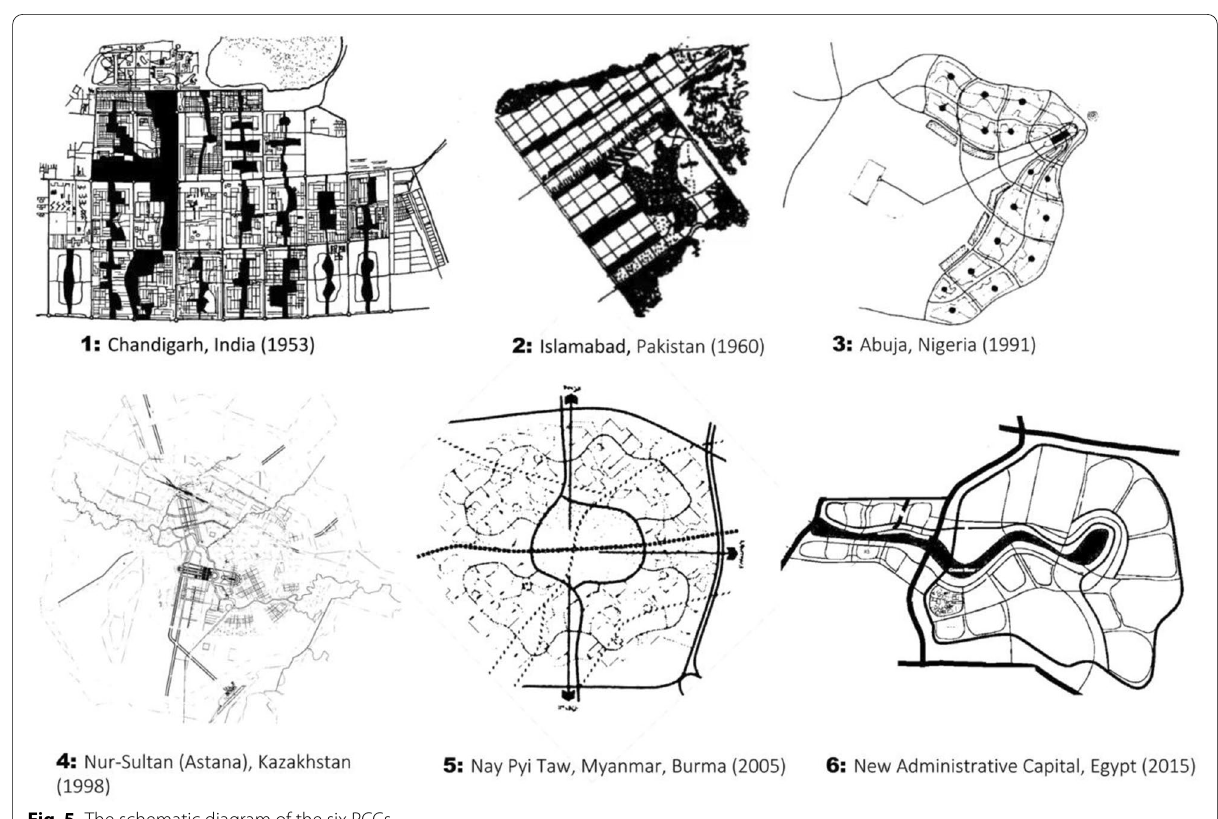
Fig. 5 The schematic diagram of the six